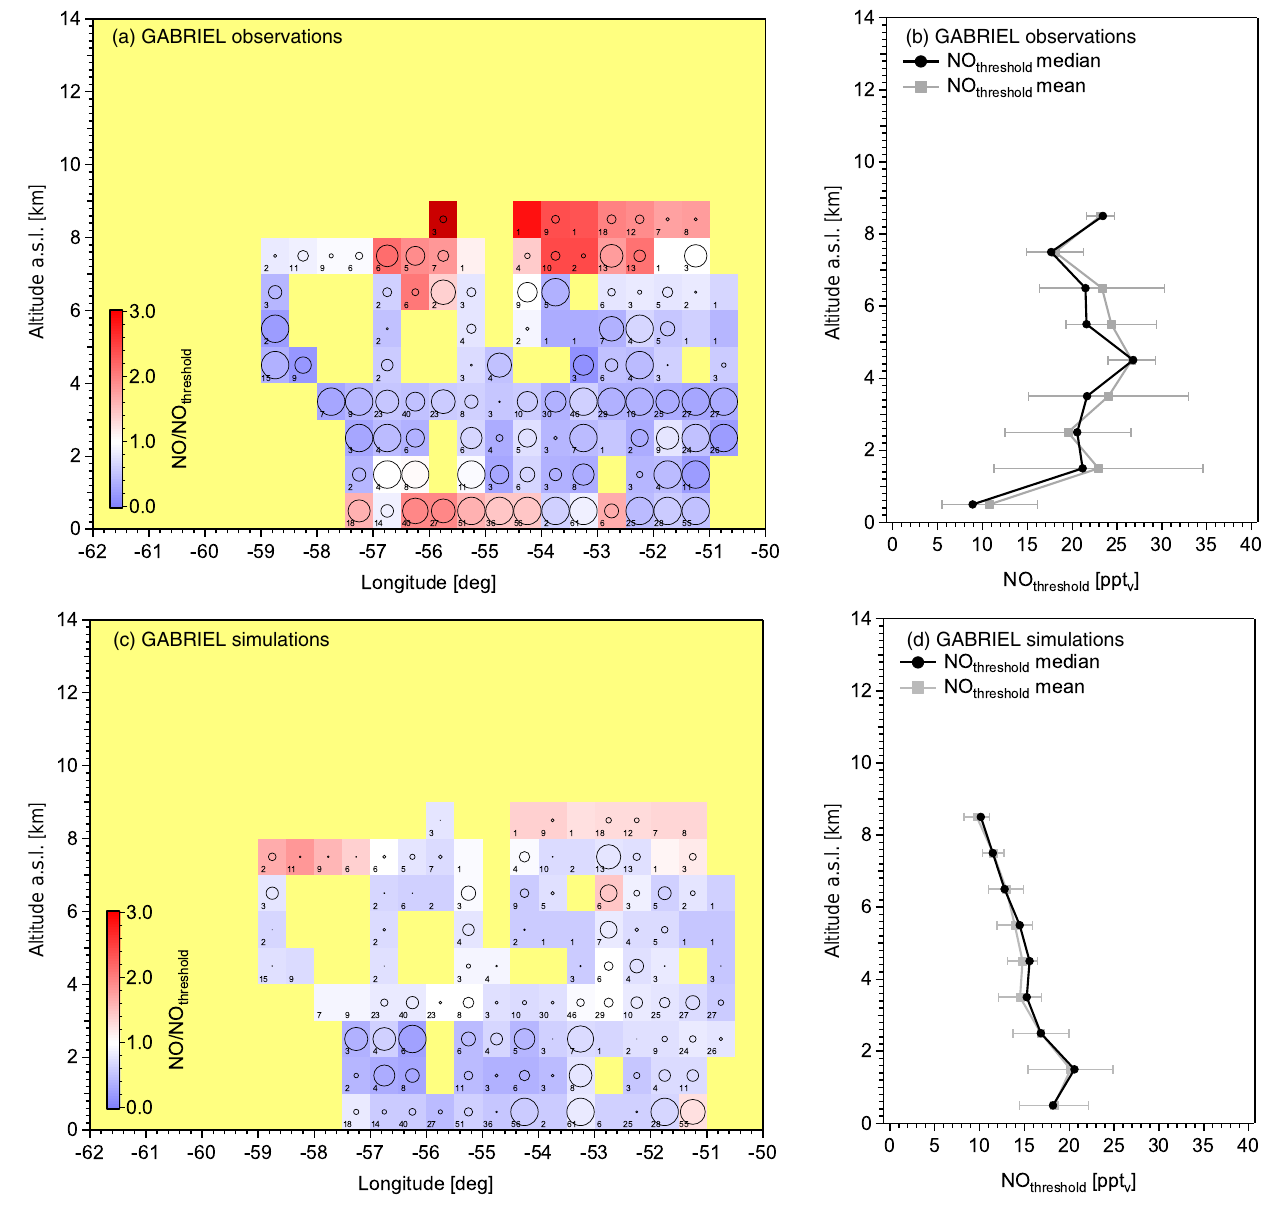
Figure 3. Ratio of NO to NO th deduced from in situ data (a) and MATCH simulations (c) for GABRIEL. Altitude profiles for NO th are given in panel (b) for the observations and in panel (d) for model